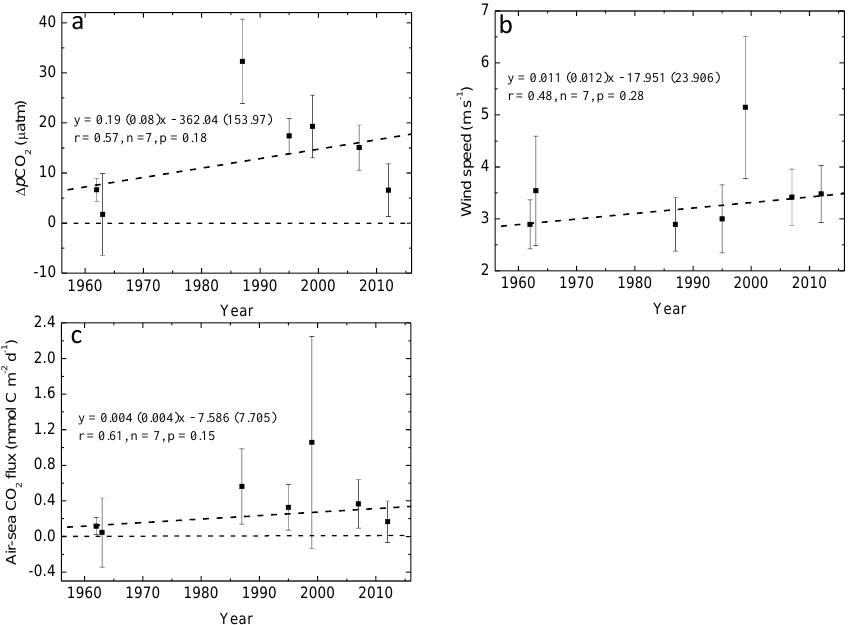
Figure 5. Temporal changes in the difference of p CO 2 between the atmosphere and the ocean ( (cid:49)p CO 2 = p CO 2 water − p CO 2 air ) (a) , wind speed (b) , and air–sea CO 2 flux (c) . All data are corrected to the same month (April). − 0.0016 ± 0.0001 yr − 1 from 1962 to 2012 (Fig. 6),